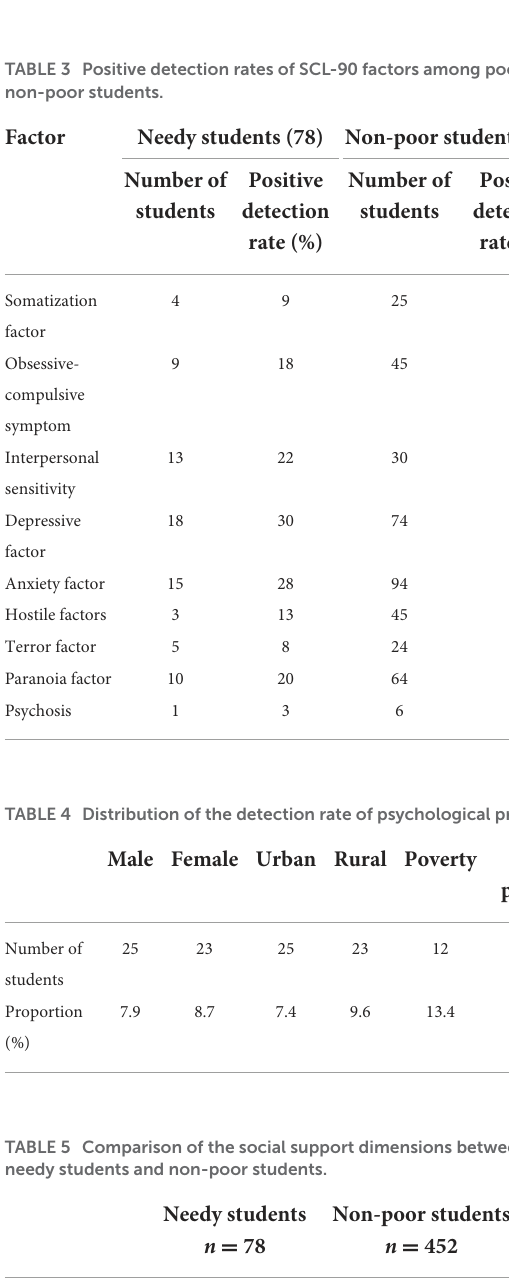
TABLE 6 Analysis of social support dimension and SCL-90